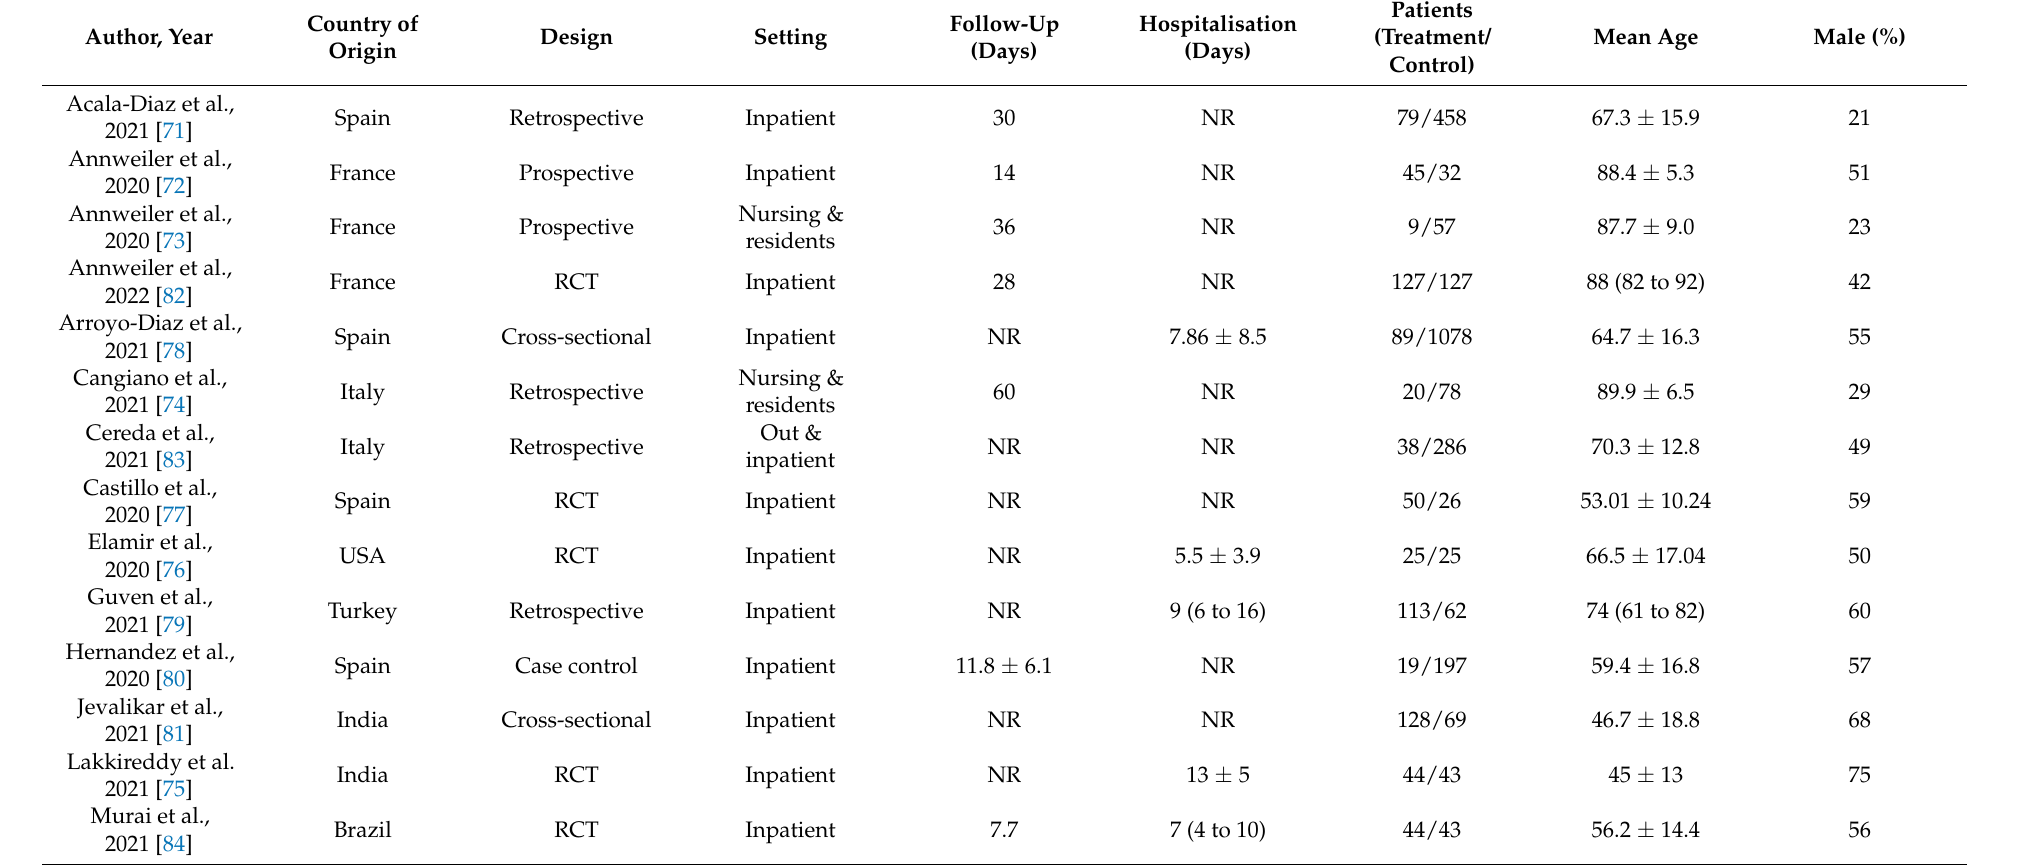
Table 1. Studies which investigated Vit D implementation in